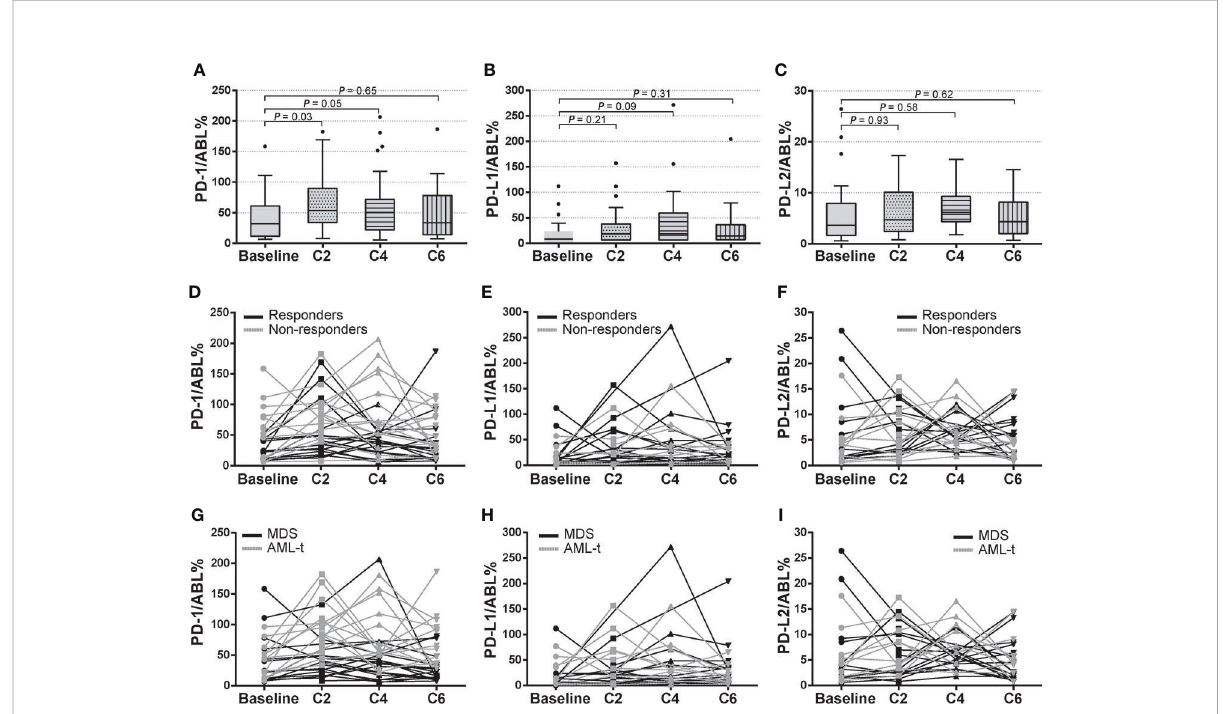
FIGURE 3 Dynamics of PD-1, PD-L1, and PD-L2 expression in HMA treatment cycles. (A – C) Pre-treatment and post-treatment expression of PD-1, PD-L1, and PD-L2 in HMA treatment cycles in MDS patients who received at least 2-cycle of HMA treatment. (D – F) Dynamic expression of PD-1, PD- L1, and PD-L2 in HMA treatment cycles in HMA responders and HMA non-responders. (G – I) Dynamic expression of PD-1, PD-L1, and PD-L2 in HMA treatment cycles in MDS patients with or without AML transformation event. Results were presented as mean ± SEM of independent